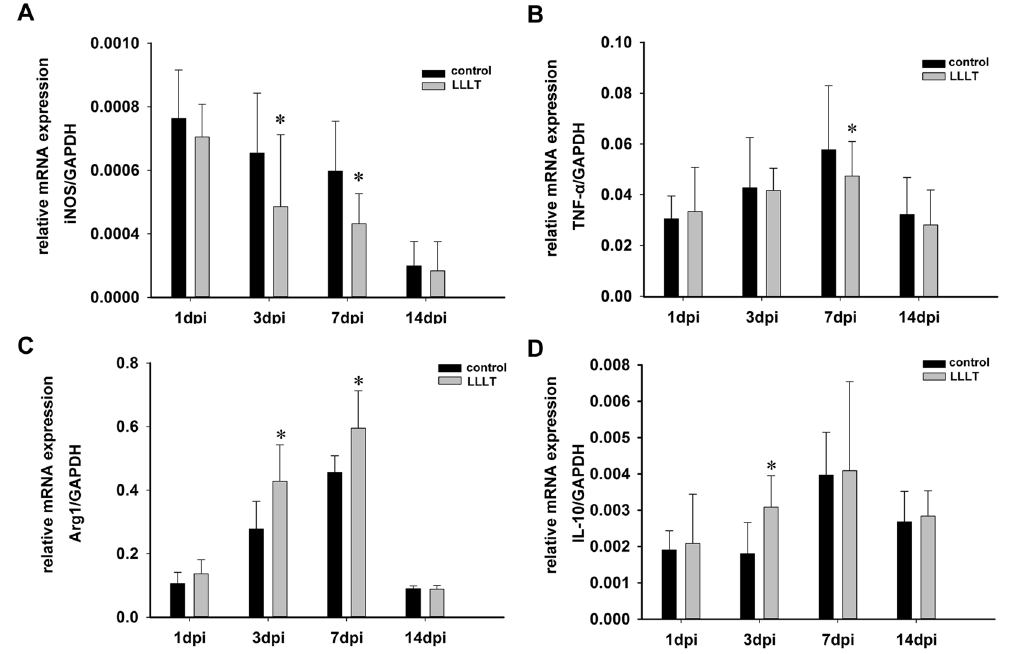
Figure 4. LLLT reduces mRNA expression of the M1 marker, but increases expression of M2. ( A ) Quantitative analysis of mRNA expression of M1 markers, iNOS. ( B ) Quantitative analysis of mRNA expression of M1 markers, TNF- α . ( C ) Quantitative analysis of mRNA expression of M2 markers, Arg1. ( D ) Quantitative analysis of mRNA expression of M2 markers, IL-10. iNOS, inducible nitric oxide synthase. Arg1, arginase 1. TNF- α , tumour necrosis factor-alpha. IL-10, interleukin 10. (n = 3 rats per group per time point * P < 0.05; compared with control).